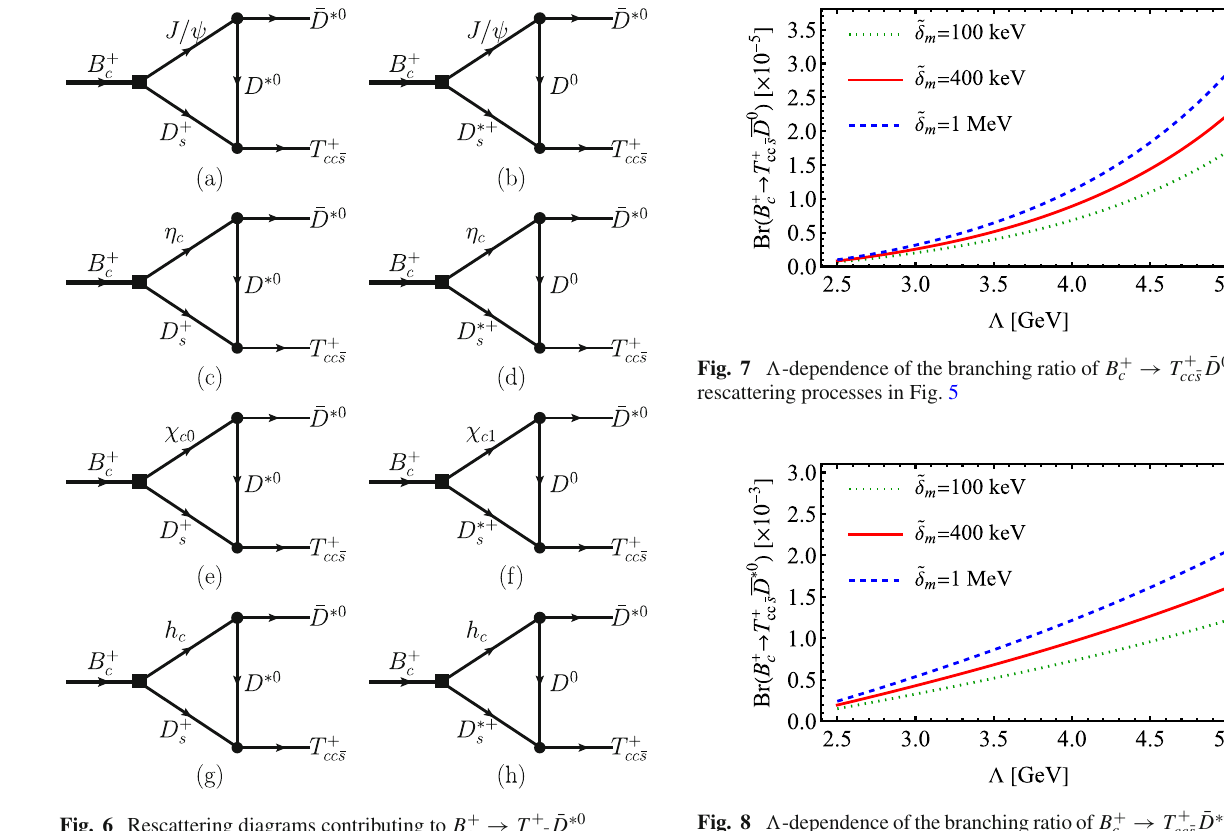
Fig. 6 Rescattering diagrams contributing to B + c → T +